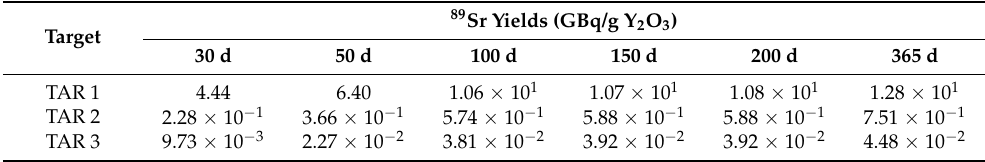
Table 3. 89 Sr yields of Y 2 O 3 at various irradiation times